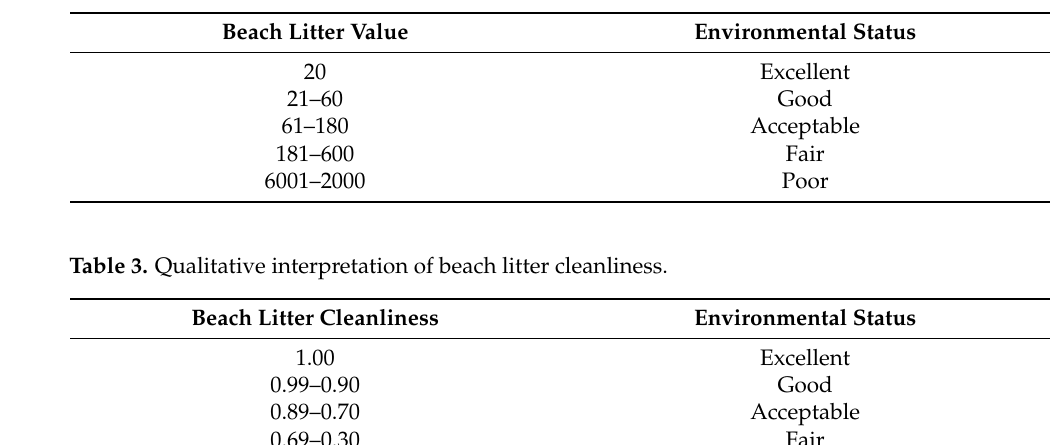
Table 2. Qualitative interpretation of beach litter values.